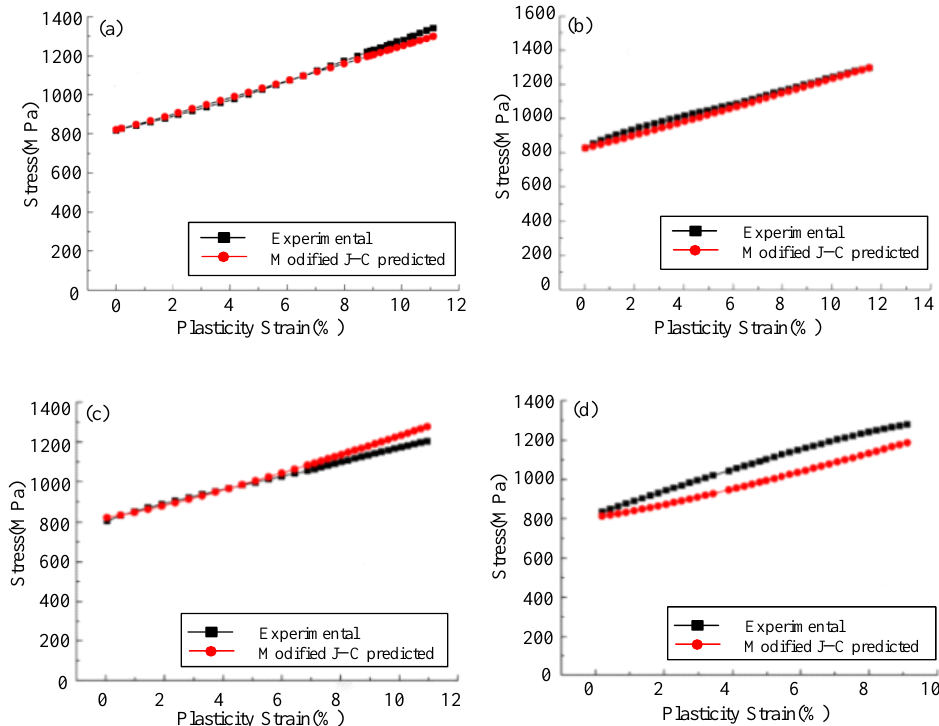
Figure 1. The predicted results of IC10 alloy based on the modified J – C model [13], ( a ) T =25 ℃ , 𝜀̇ = 0.00001𝑠 −1 , ( b ) T =600 ℃ , 𝜀̇ = 0.0001𝑠 −1 , ( c ) T =700 ℃ , 𝜀̇ = 0.0001𝑠 −1 , ( d ) T =800 ℃ , 𝜀̇ = 0.0001𝑠 −1 .